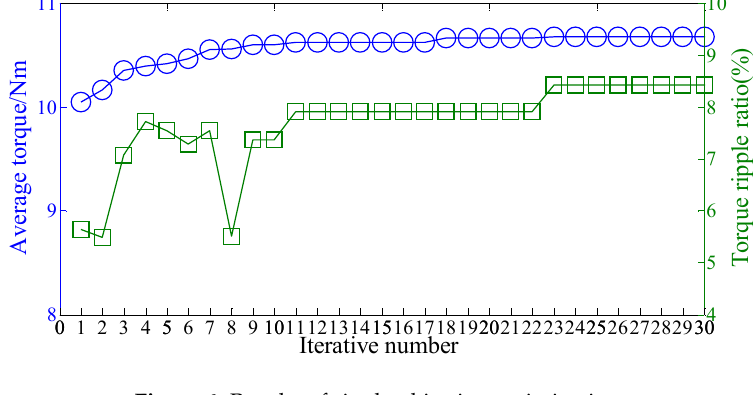
Figure 6. Results of single-objective optimization. Table 2. Design parameters.